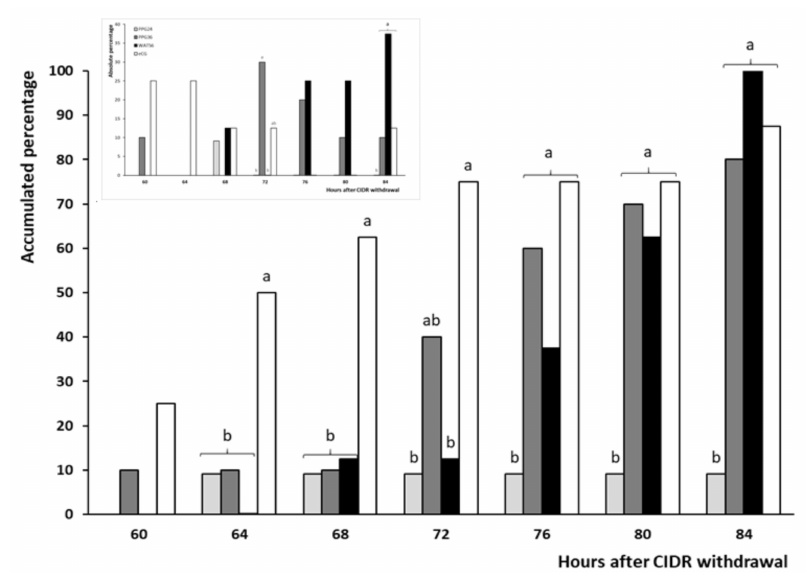
Figure 6. Timing of onset of ovulation in ewes treated with one CIDR with PGF 2 α and 400 IU of eCG (at CIDR removal; group eCG, white bars) or 50 µ g of GnRH in either distilled water (56 h after CIDR removal; group WAT56, black bars) or propylene-glycol (24 or 36 h after CIDR removal; groups PPG24 and PPG36, with light and dark grey bars, respectively). Cumulative percentage of animals is represented in the main panel, whereas absolute percentages in each interlude are represented in the inset graph. Di ff erent letters indicate statistical di ff erences between groups (a (cid:44) b: p < 0.05).